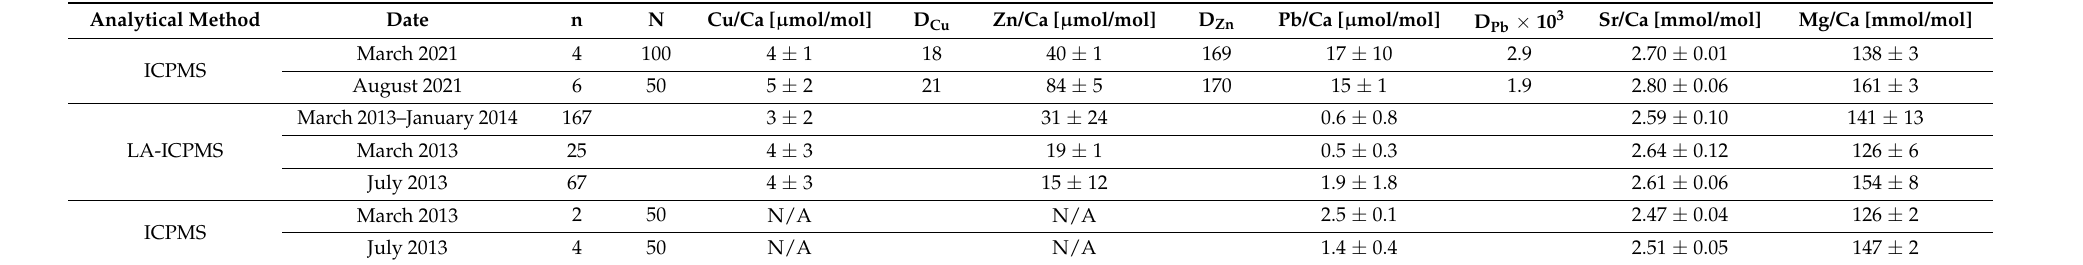
Table 2. Metal/Ca and partition coefficients in P. calcariformata . Details same as in Table